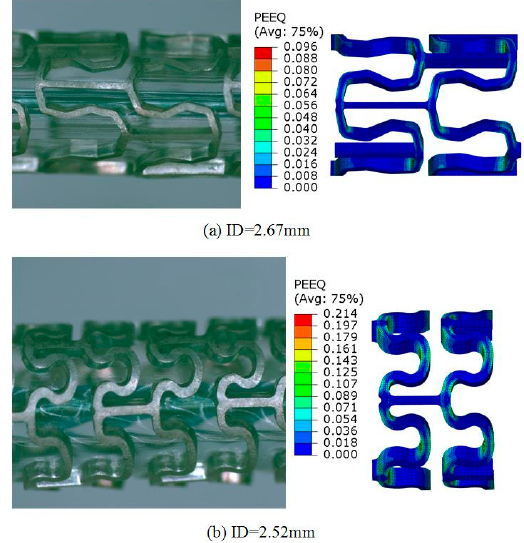
Figure 16. Experimental and simulated profiles of ( a ) Stent B and ( b ) Stent C expanded to the specific inside diameters.